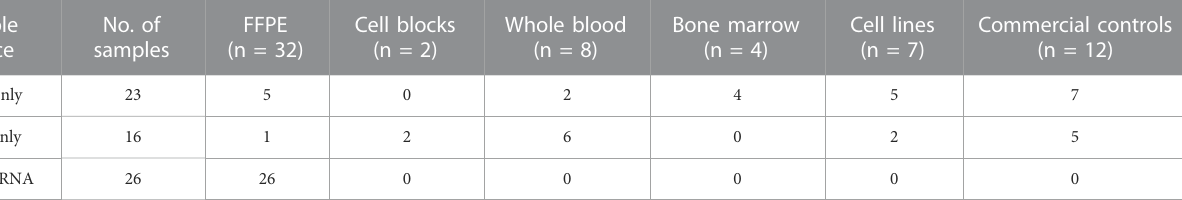
TABLE 2 Study Cohort. Summary of clinical specimens and commercial controls used in study (n = 65). Sample